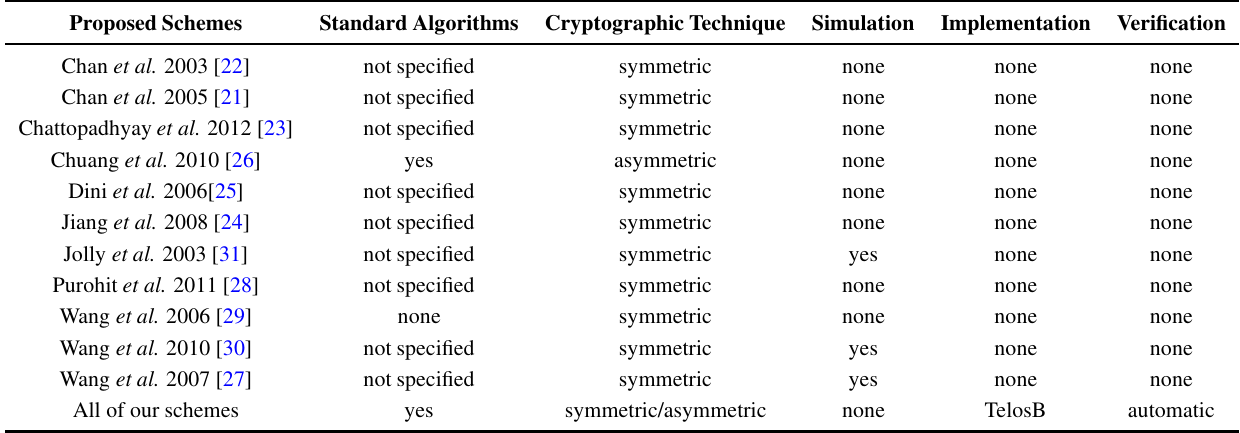
Table 1. Comparison of related work schemes and our